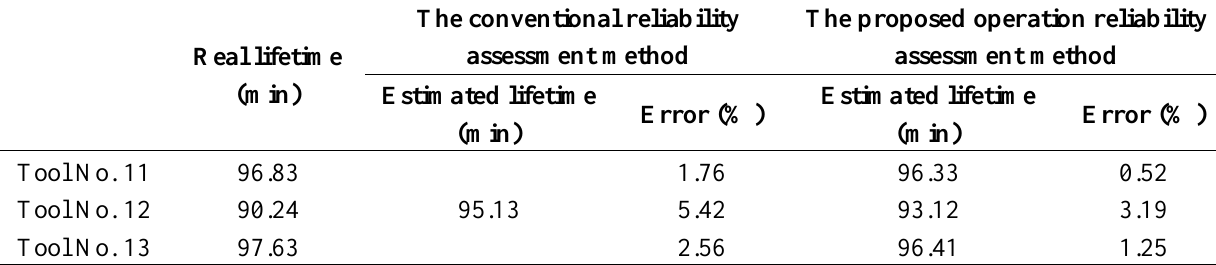
Table 3. Reliability assessment results of the proposed method compared with those of the conventional method.